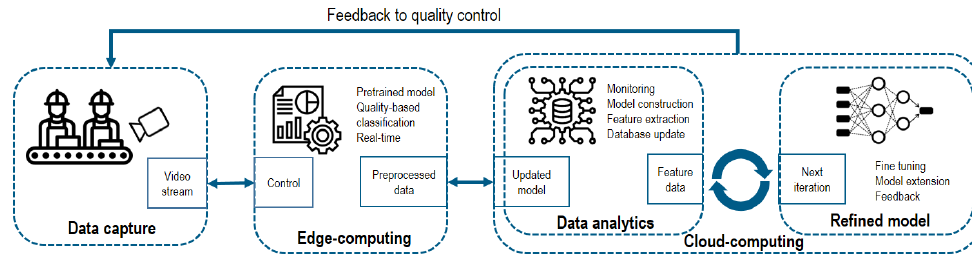
Figure 5. General architecture model for vision-based product quality inspection